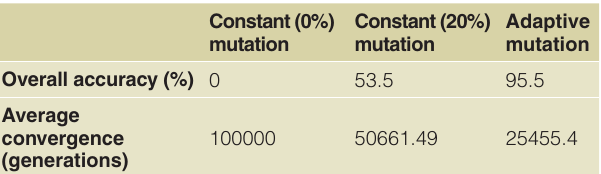
Table 2. Summary of results from solving the 3-dimensional maximization problem using various mutation